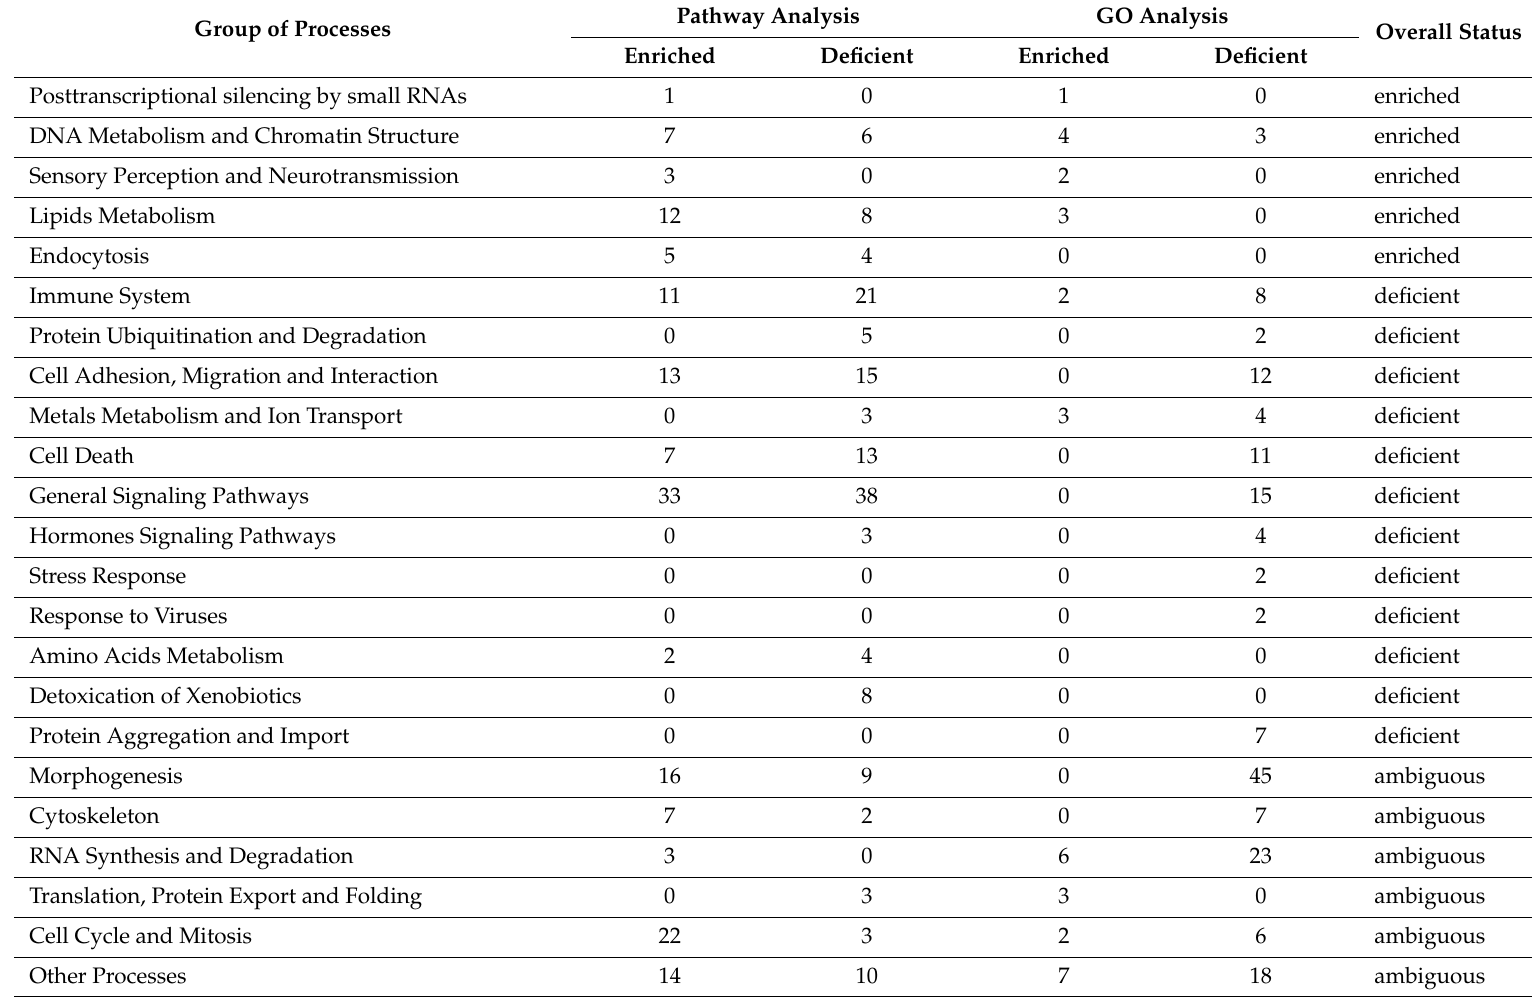
Table 2. RRE enrichment of the molecular processes according to GO and pathway analyses. Group of